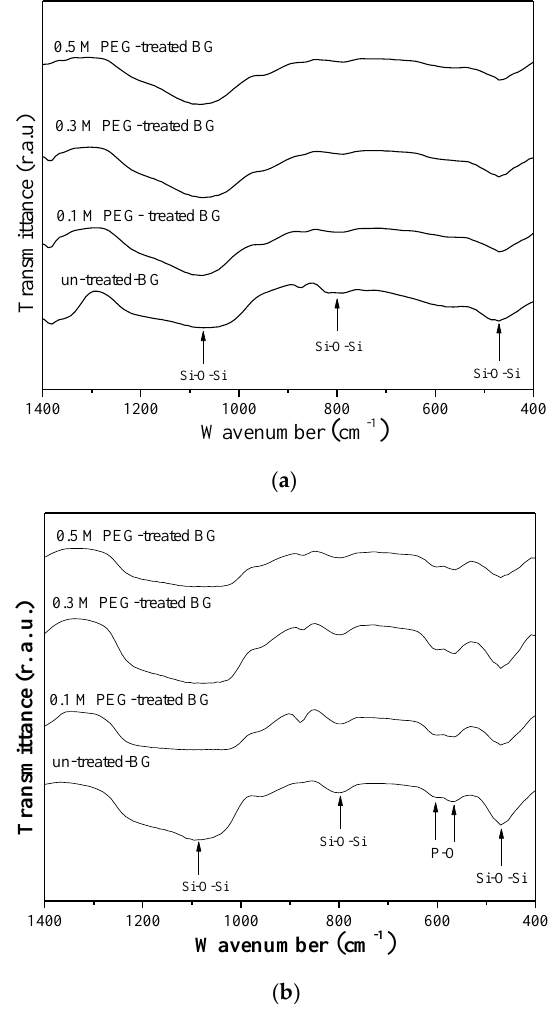
Figure 7. FTIR spectra of un-treated, 0.1 M, 0.3 M, and 0.5 M PEG-treated BG powders ( a ) before and ( b ) after being immersed in SBF for one day.